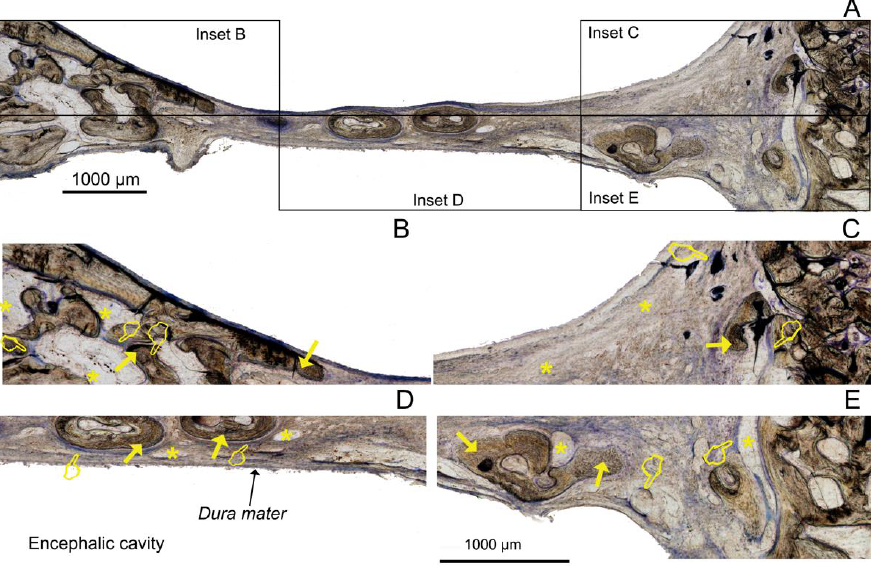
Figure 5. Bone histology obtained after using Dox-HOOC-Si-loaded membranes dyed with toluidine blue to visualize mineralized bone at 6 weeks of healing time. Single arrows point to the presence of new bone area (NBA). Osteoid area (OA) is signaled by pointers, and soft tissue area (STA) is indicated by asterisks. ( A ) General view. Insets AB, AC, AD, and AE reflect the corresponding areas analyzed in Figure 5B–E; ( B ) indicates a partial view of R1 area (top left); ( C ) R3 (top right); ( D ) R5 (bottom central); and ( E ) R6 (bottom right). ( B , C ) show zones with the lowest NBAs observed (R1). ( D ) permits the observation of soft tissue that was present in higher proportion when compared with the rest of the groups after using this doxycycline-doped membrane. ( E ) shows a relatively low proportion of STA and a high proportion of NBA in comparison with the rest of the regions within this group of